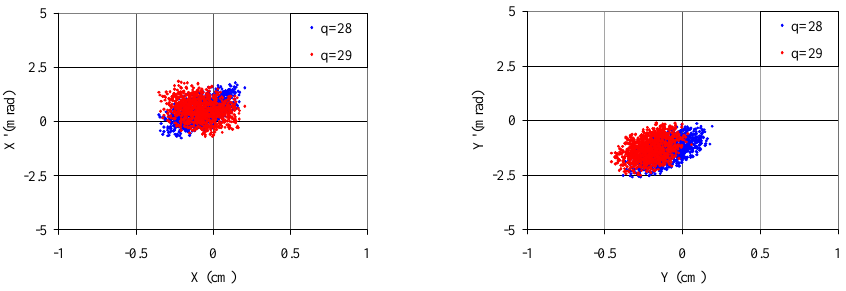
FIG. 3. (Color) Transverse phase space plots of uranium beam at charge states 28 and 29 simulated through 42 QWRs.